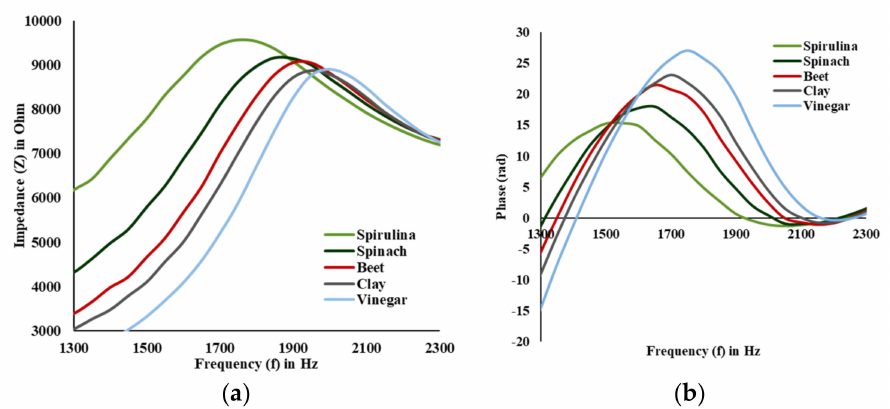
Figure 9. The EIS sensor’s selectivity for the measurement of algae species in water: ( a ) the impedance response of the matters at different frequencies (Spirulina, 1.75 kHz; Spinach, 1.85 kHz; Beet, 1.9 kHz; Clay, 1.95 kHz; and Vinegar, 2 kHz), and ( b ) the corresponding phase of the impedance of the matters.